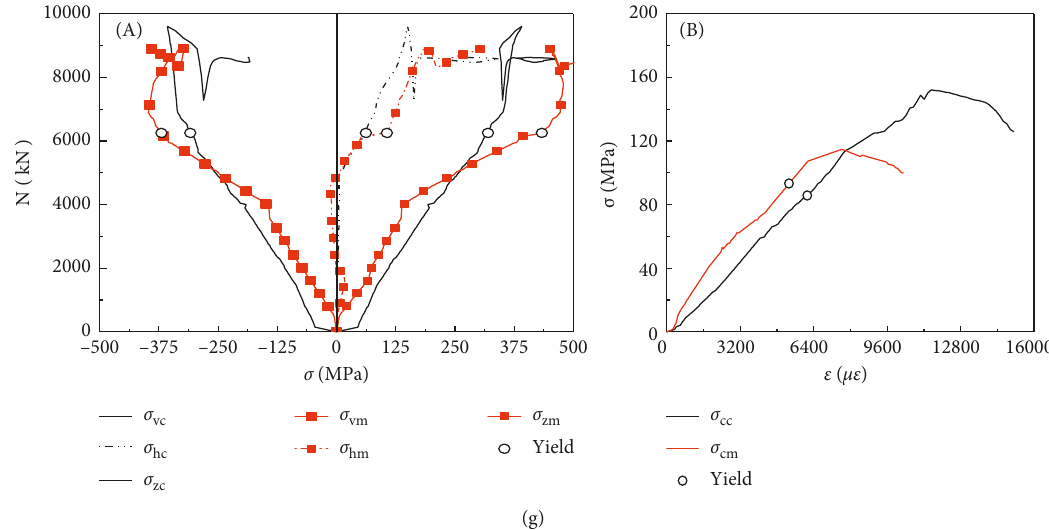
Figure 9: Stress-strain analysis results of RFCTspecimens. (A) Envelope curves of load-steel stress and (B) stress-strain curves of RPC core for (a) 219-8, (b) 219-10, (c) 219-12, (d) 245-8, (e) 245-12, (f) 273-8, and (g)